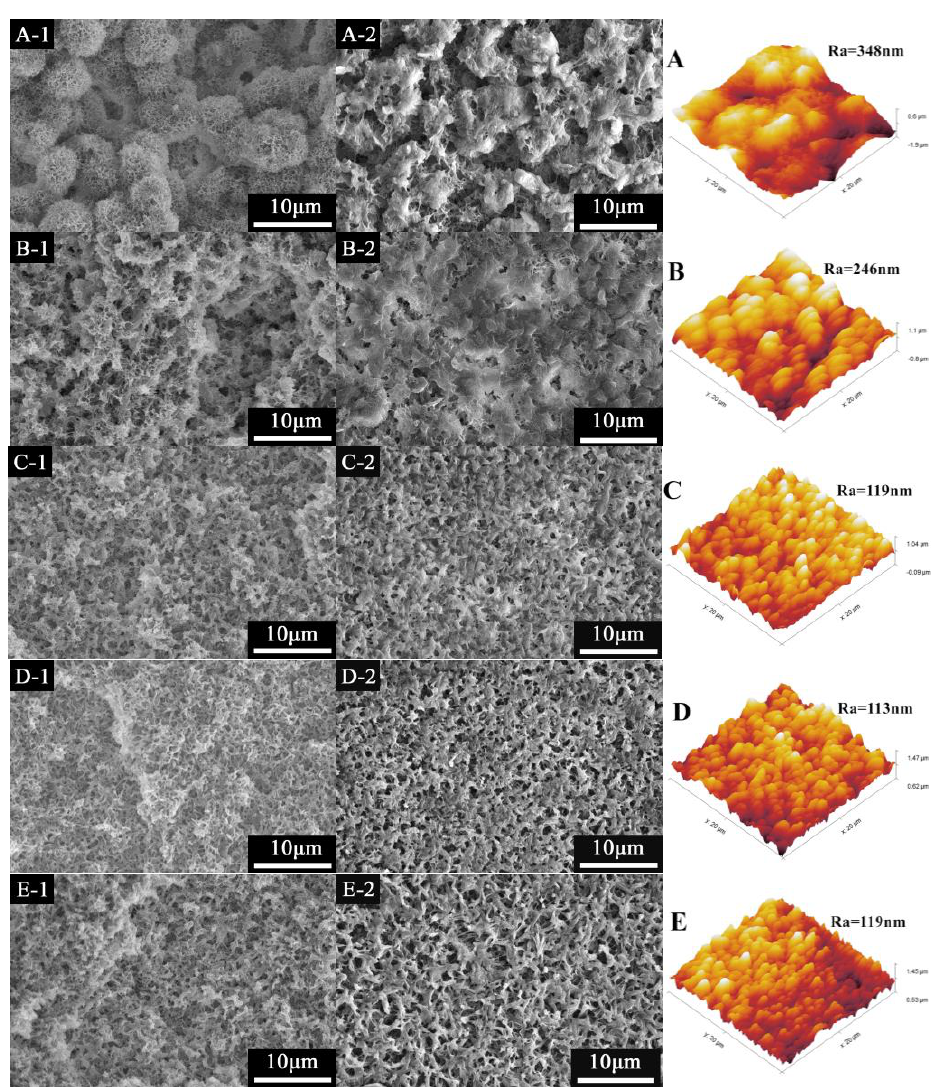
Figure 3. The SEM and AFM morphology of PVDF-HFP membrane: ( A – E ) M0–M4 (1: cross section; 2: surface).